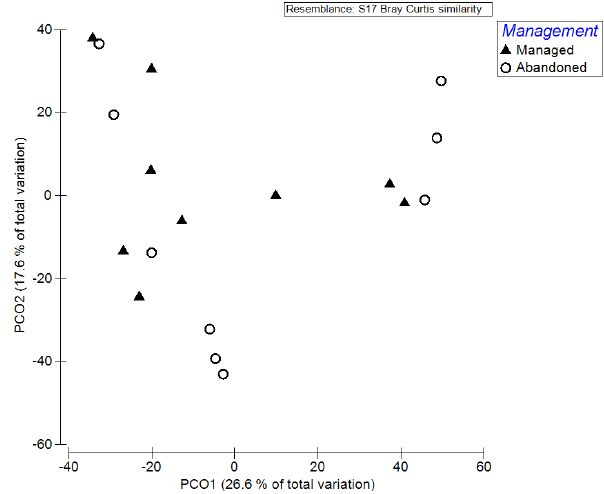
Figure 3. Principal coordinate analysis (PCO) showing hoverfly species composition in managed ( (cid:78) ) and abandoned ( (cid:13) )